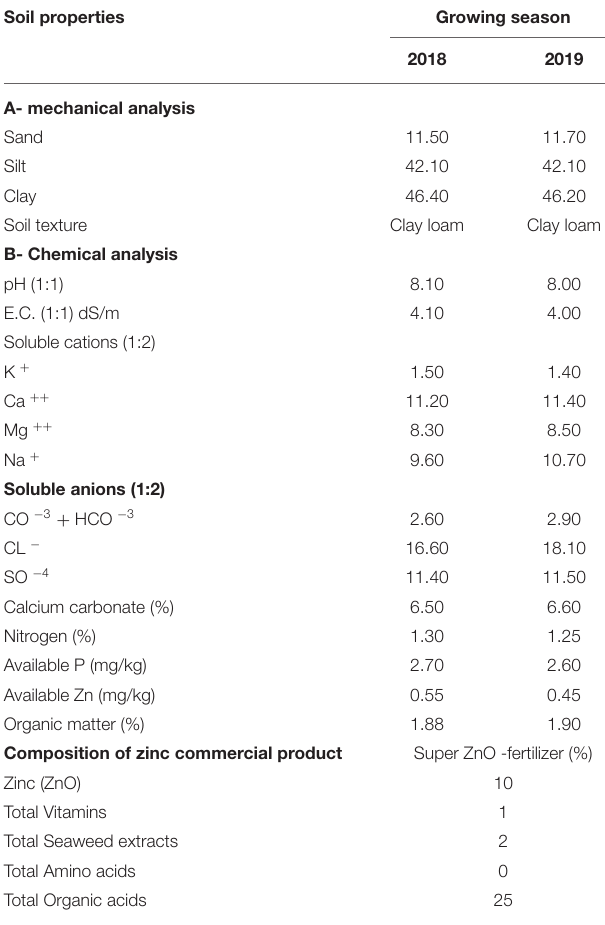
TABLE 1 | Physical and chemical properties of the experimental soil site in both seasons (2018 and 2019), in addition to the composition of zinc commercial product